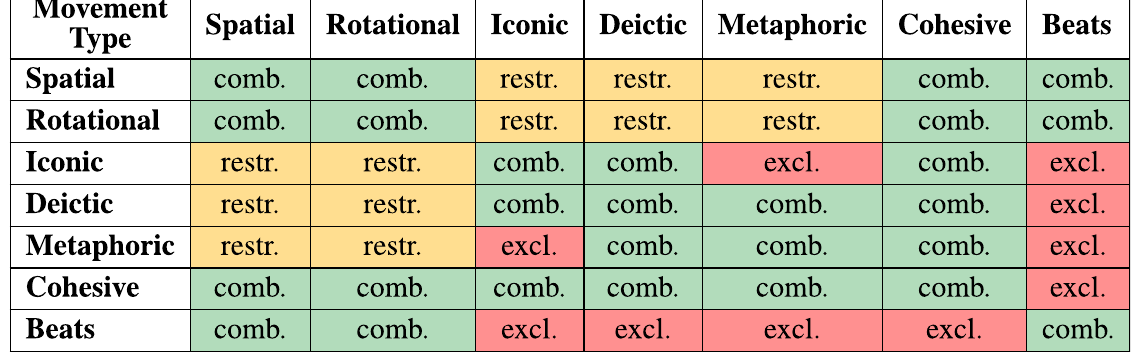
Frontiers in Robotics and AI |